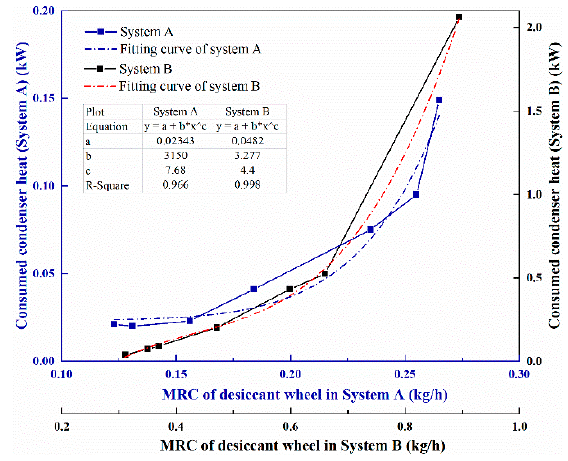
Figure 13. Relationship between the MRC of the desiccant wheel and the condenser heat.